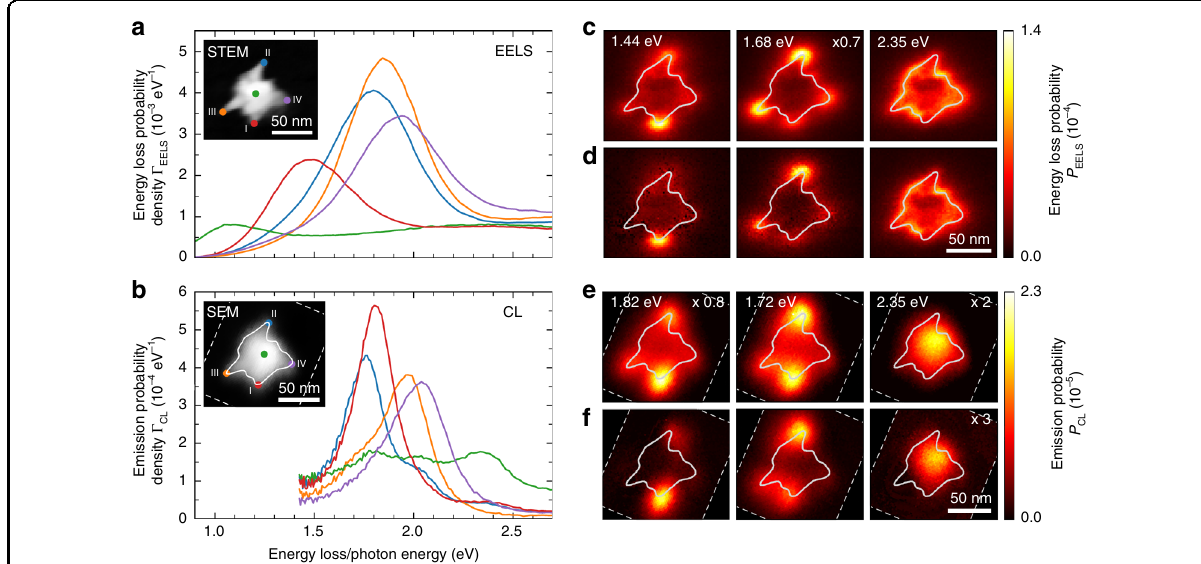
Fig. 2 EELS and CL measurements. a 200 keV STEM-EELS and b 20 keV SEM-CL spectra taken at four different tips and at the core of the same chemically synthesized Au nanostar. Electron beam positions are indicated by the color-matched dots in the insets, showing a STEM bright- fi eld image and an SEM image of the nanostar. All spectra represent an average taken over 5 × 5 neighboring pixels. Energy- fi ltered c EELS and e CL probability distributions obtained for a bandwidth of ±25 meV around the plasmon resonance energies indicated on the top. Fitted d EELS and f CL probability distributions, revealing the extracted contribution of the tip plasmon resonances to the raw energy- fi ltered maps in c and e . The acquisition boundaries of the CL data set are indicated by the thin dashed lines in b , e , and f . The solid lines superimposed on the EELS and CL maps and the SEM image illustrate the approximate contour of the nanostar as inferred from the STEM bright- fi eld image in a